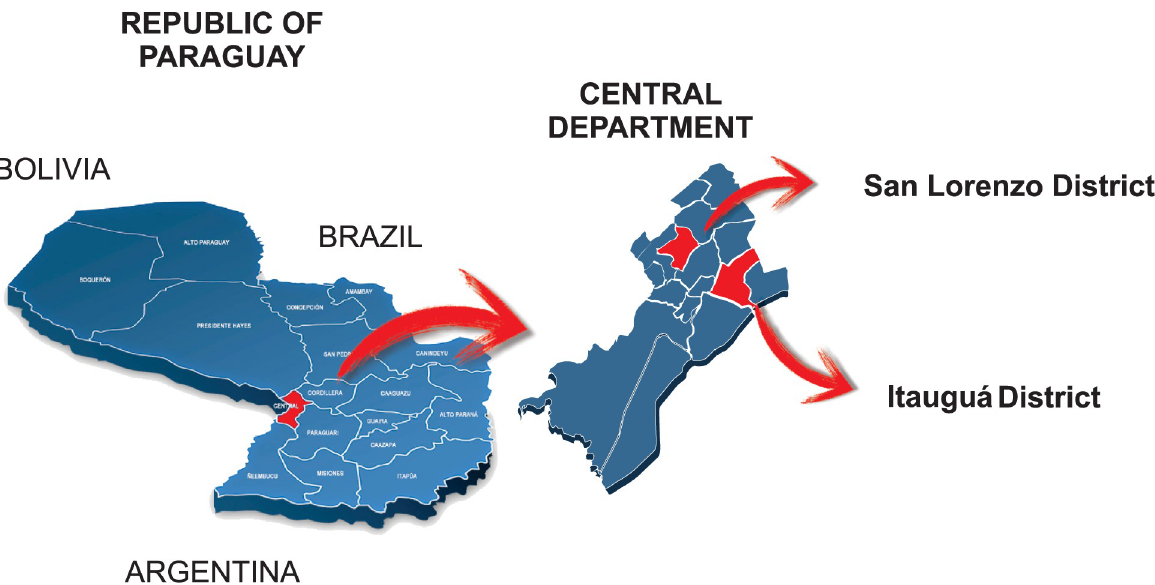
Fig 1. Map showing the political division of Paraguay, the location of Central Department and Itaugua´ and San Lorenzo Distrits.